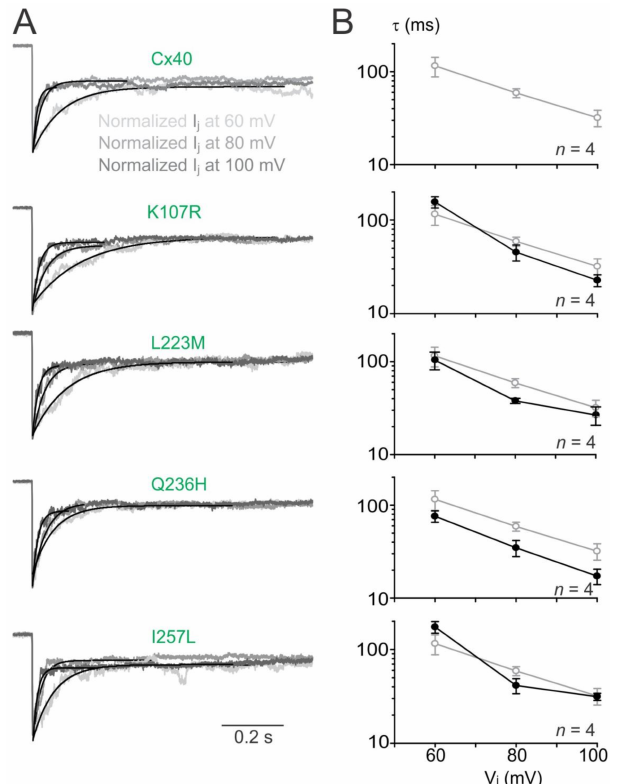
Figure 4. V j -gating kinetics of AF-linked Cx40 mutants. ( A ) I j s induced at different V j s (60 mV light grey, 80 mV medium grey, 100 mV dark grey) were normalized and superimposed for each of the mutant or Cx40 GJs. I j deactivations under different V j s were all fitted well with a single exponential process (smooth black lines); ( B ) The time constants ( τ s) were plotted on a semi logarithmic scale against different V j s. When the V j s increased, the averaged τ s of the mutant GJs (black filled circles) decreased similar to those observed for the wildtype Cx40 (grey open circles). No consistent statistical difference was found between most of the mutant τ s and the τ s of wildtype Cx40, except the τ s of Q236H was consistently lower than those of wildtype Cx40 (two-way ANOVA). The number of cell pairs are